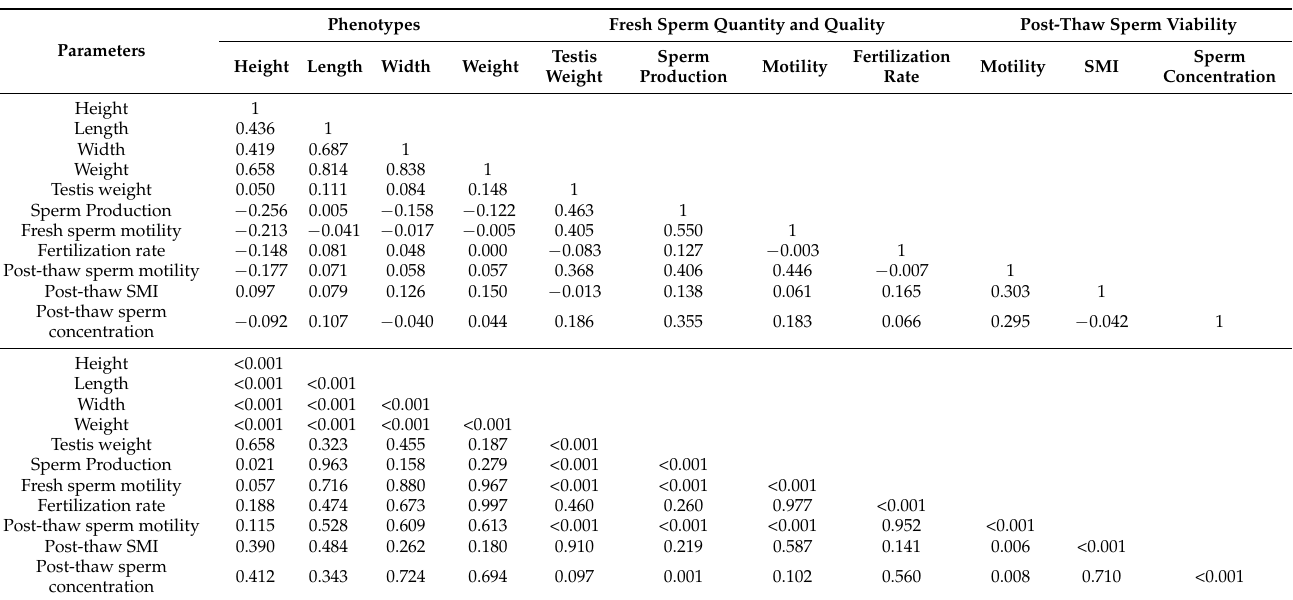
Table 3. The correlation coefficients (R values) (upper panel) and p- values (lower panel) among shell metrics (mm), whole body weights (g), testis weight (g), total sperm production (cells), fresh sperm fertility (%), post-thaw sperm motility (%), post-thaw sperm membrane integrity (SMI, %), and post-thaw sperm concentration (cells/mL) of Eastern oysters Crassostrea virginica across all sampling